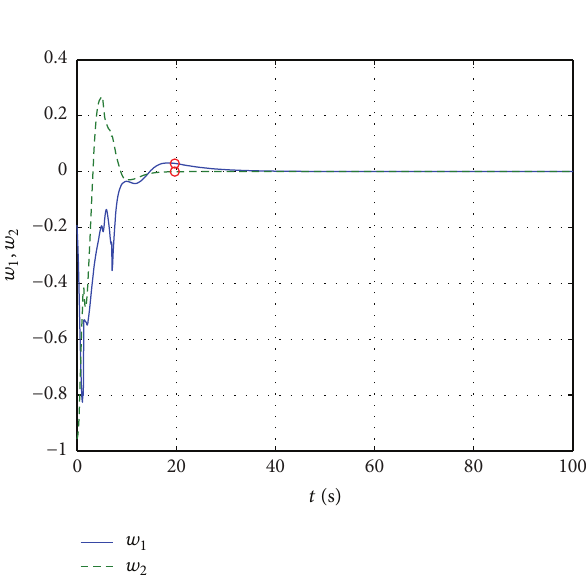
Figure 3: Response of 𝑢 , V , and 𝑟 .